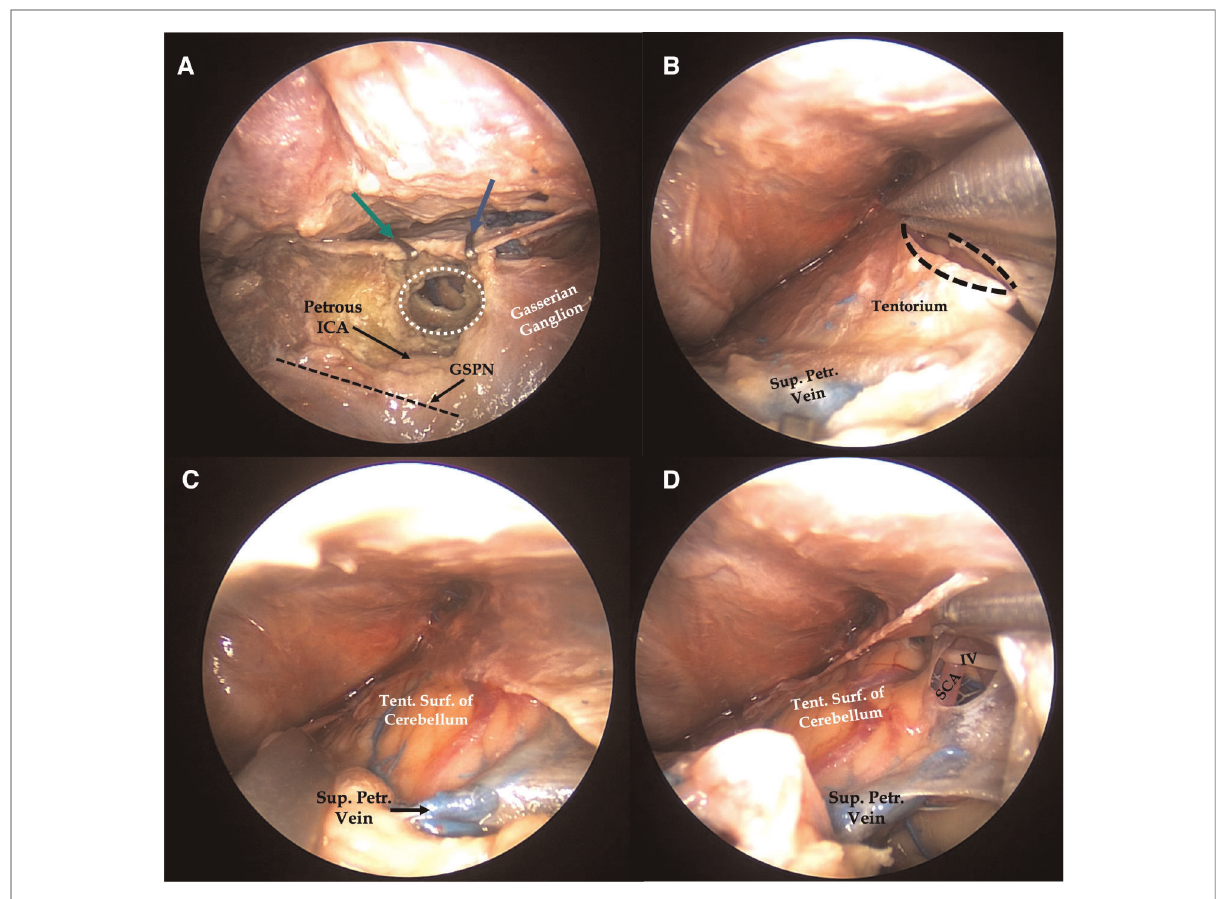
FIGURE 3 Right endoscopic transorbital approach to the tentorial incisura. After exposure of the petrous apex, two surgical clips (green and blue arrows) are positioned to the superior petrosal sinus before the tentorium cut. After identi fi cation of the anatomical landmark of Kawase ’ s quadrilateral, the petrous apex is drilled ( A ). Tentorium cut is extended posteriorly from the area of the superior petrosal sinus closed by the surgical clips ( B ), thus exposing the tentorial surface of the cerebellum, laterally ( C ), and the middle tentorial incisura, medially ( D ). White dotted area, petrous apex removed after drilling; straight dark dotted line, course of the greater super fi cial petrosal nerve; curved dark dotted lines, margins of tentorium after the cut; IV, trochlear nerve; GSPN, greater super fi cial petrosal nerve; Petrous ICA, petrous segment of the internal carotid artery; SCA, superior cerebellar artery; Sup. Petr. Vein, superior petrosal vein; Tent. Surf. of Cerebellum, tentorial surface of the